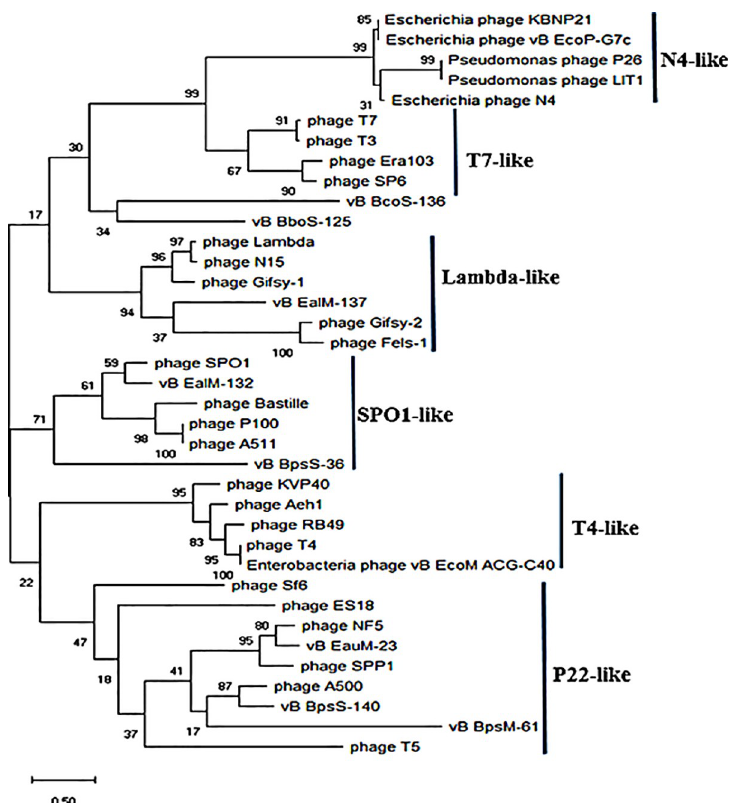
Fig 6. Phylogenetic analysis of large terminase subunits compared to phages with known DNA packaging strategies. The maximum—Likelihood tree was inferred based on ClustalW alignment of large terminase subunits amino acid sequences. The tree was rooted via midpoint rooting [34]. The numbers at the nodes represent bootstrap values based on 1,000 resamplings.